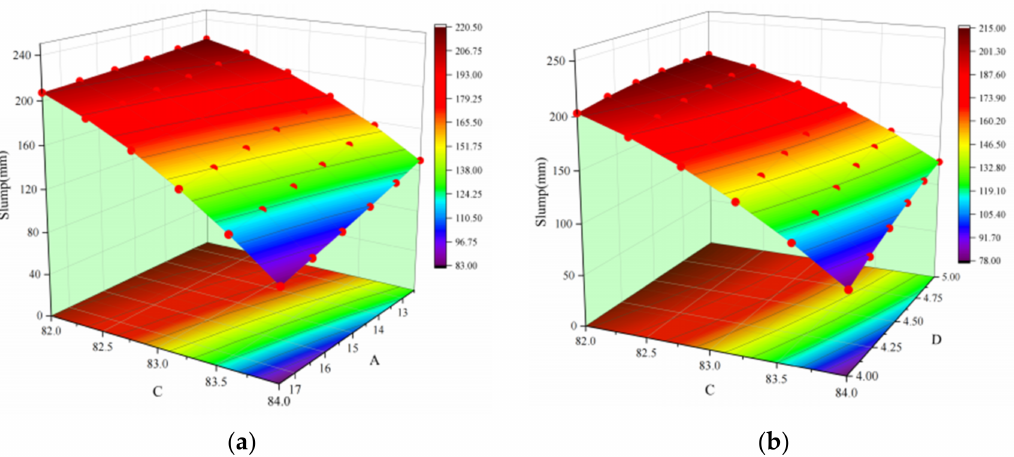
Figure 6. The effect of AC and CD interactions for slump: ( a ) the effect of AC for slump and ( b ) the effect of CD for